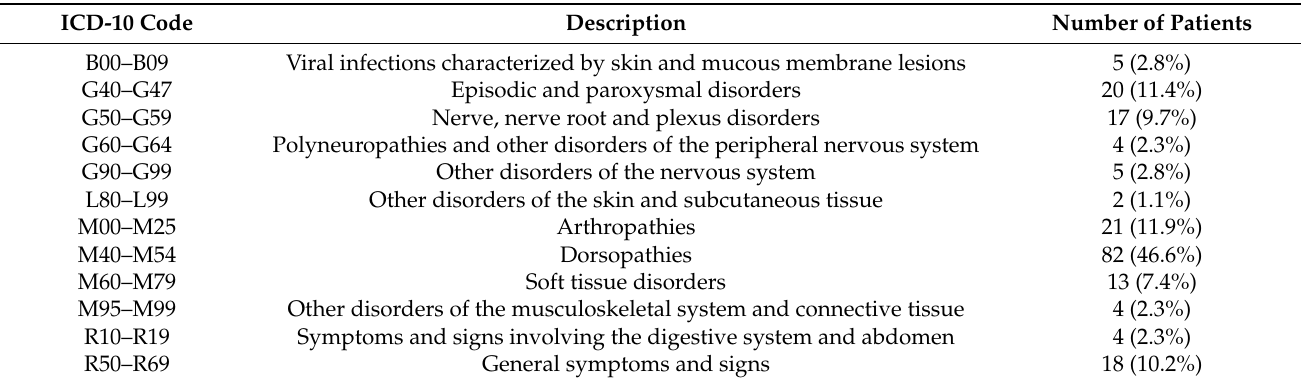
Table 1. Patient distribution by ICD